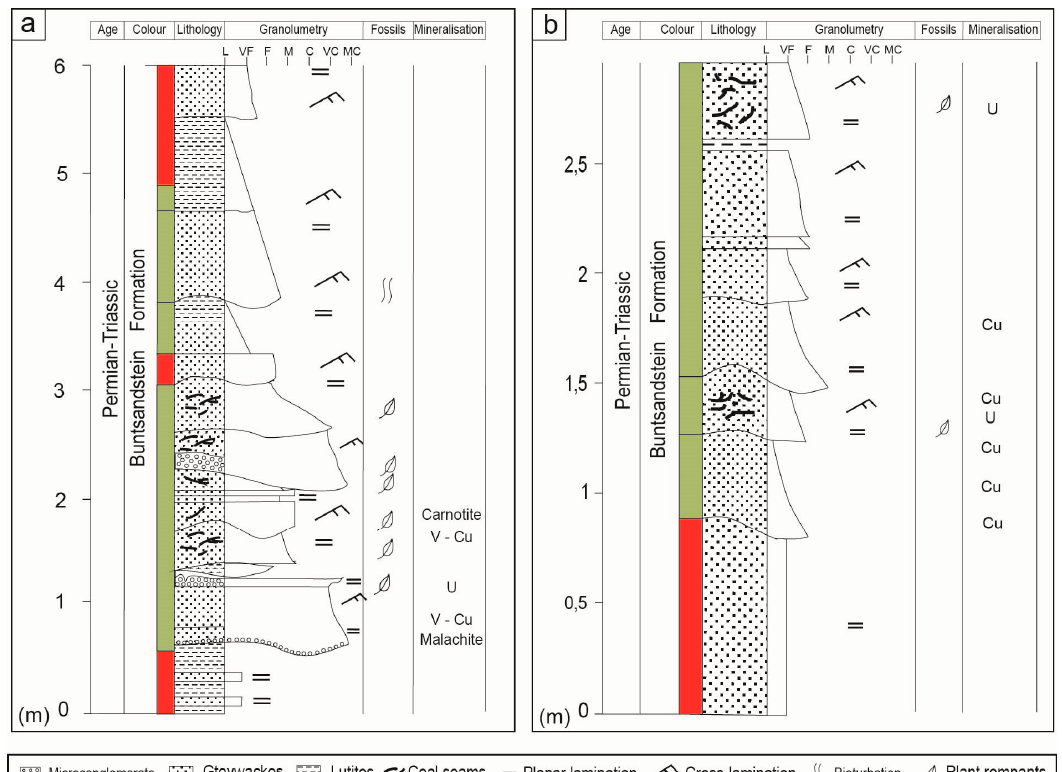
Figure 3. Stratigraphic profiles of the mineralized unit at the western outcrop at Castell-estaó ( a ) and at the easternmost outcrop ( b ). Note that the green-ish color of the sediments is commonly associated with the main coal seams, which contrasts with the red color characteristic of the red bed sandstones in the Eureka mine.